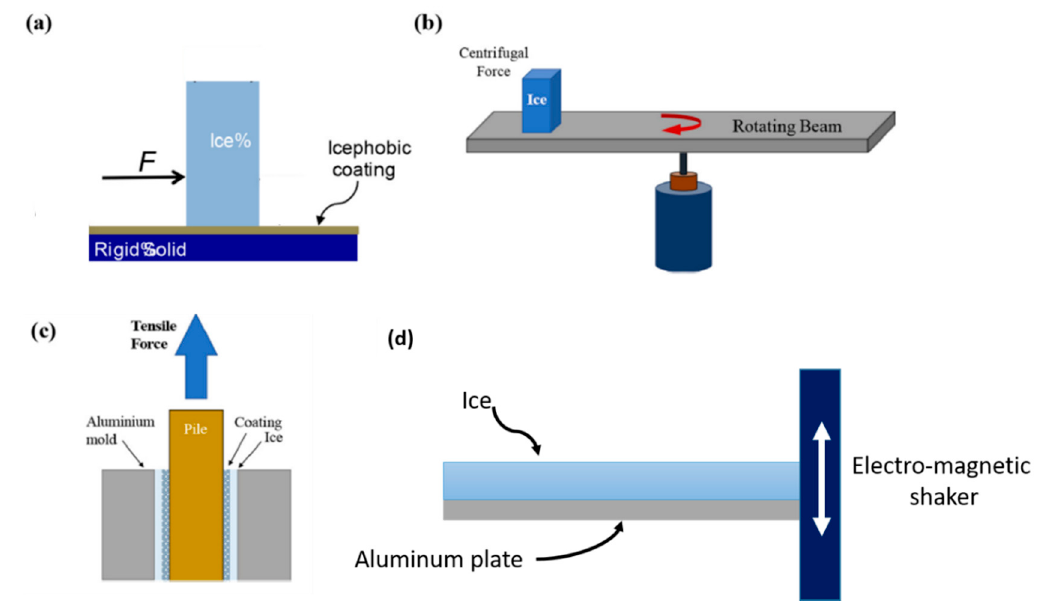
Figure 6. Schematic of the most common experimental methods for evaluating ice adhesion. ( a ) Peak force method. ( b ) Centrifugal force method. ( c ) Tensile force method. (Reprinted from [79], with